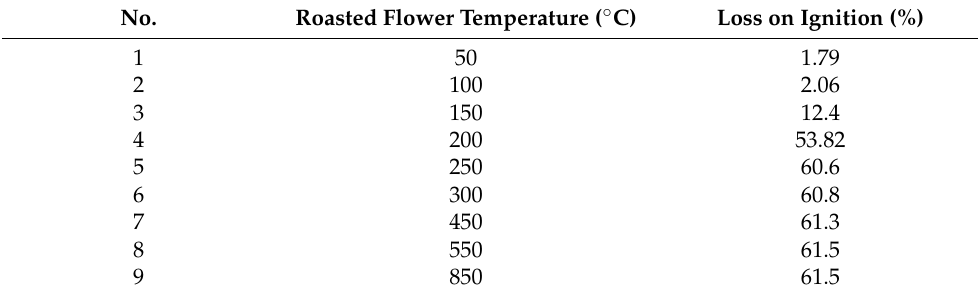
Table 2. Mass loss ratio of the side flower water transfer paper sample at different temperatures. No. Roasted Flower Temperature ( ◦